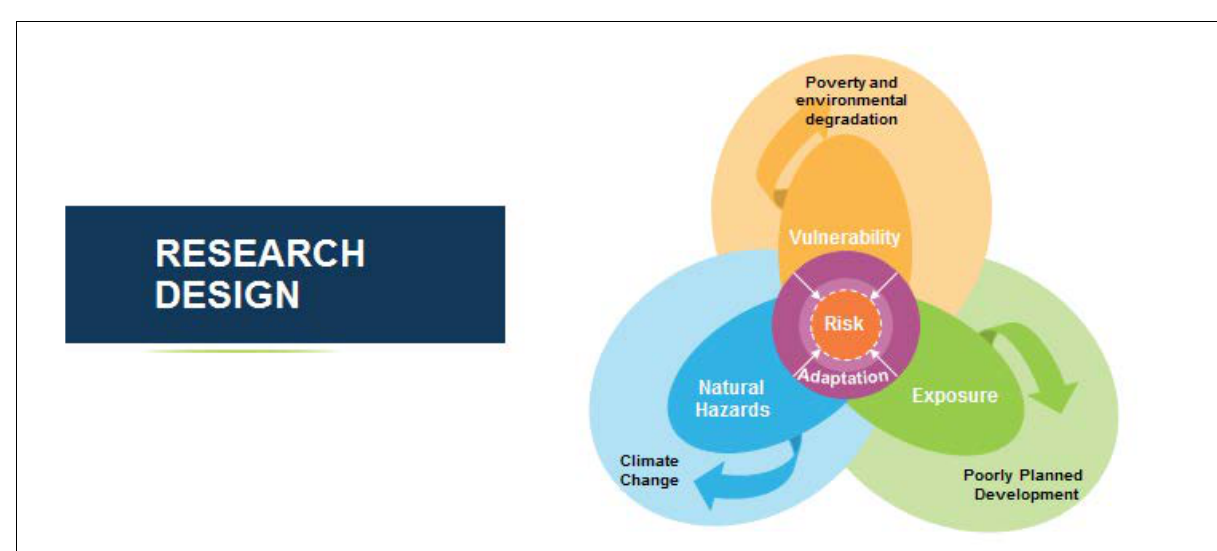
Figure 2: Green Book research design and terminologies (adapted from Niang et al. 8